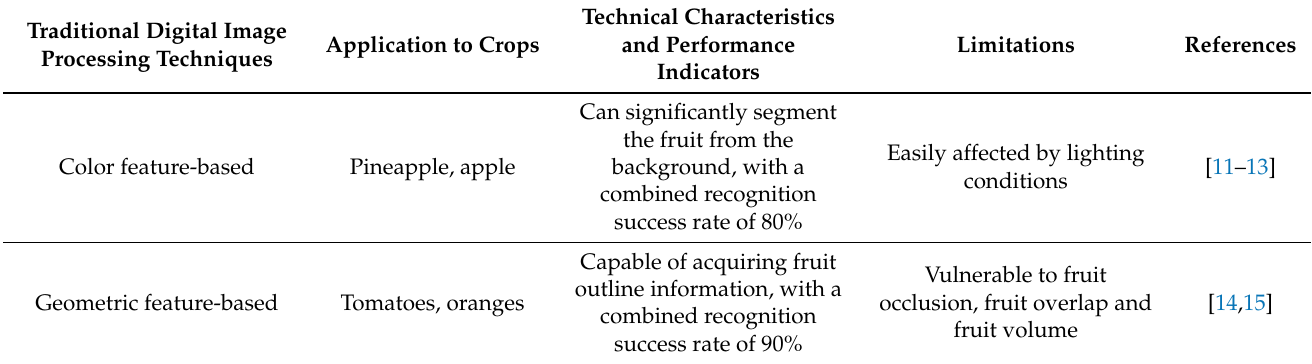
Table 1. Comparison of research results of traditional digital image processing